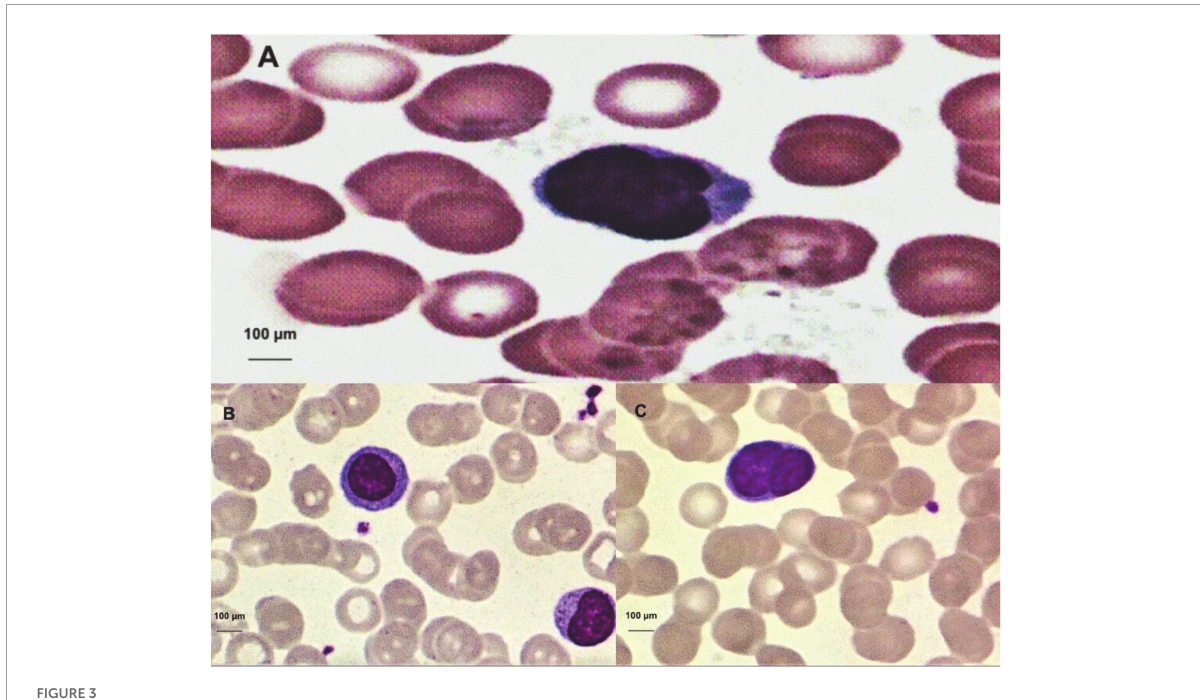
FIGURE3 (A) Trilobulate atypical lymphocyte, image obtained through microscopic visualization, and the human T-lymphotropic virus type 1 (HTLV-1)-positive patient. (B) Atypical lymphocyte with large diameter and abundant cytoplasm (upper left). (C) Bilobulateaty atypical lymphocyte.